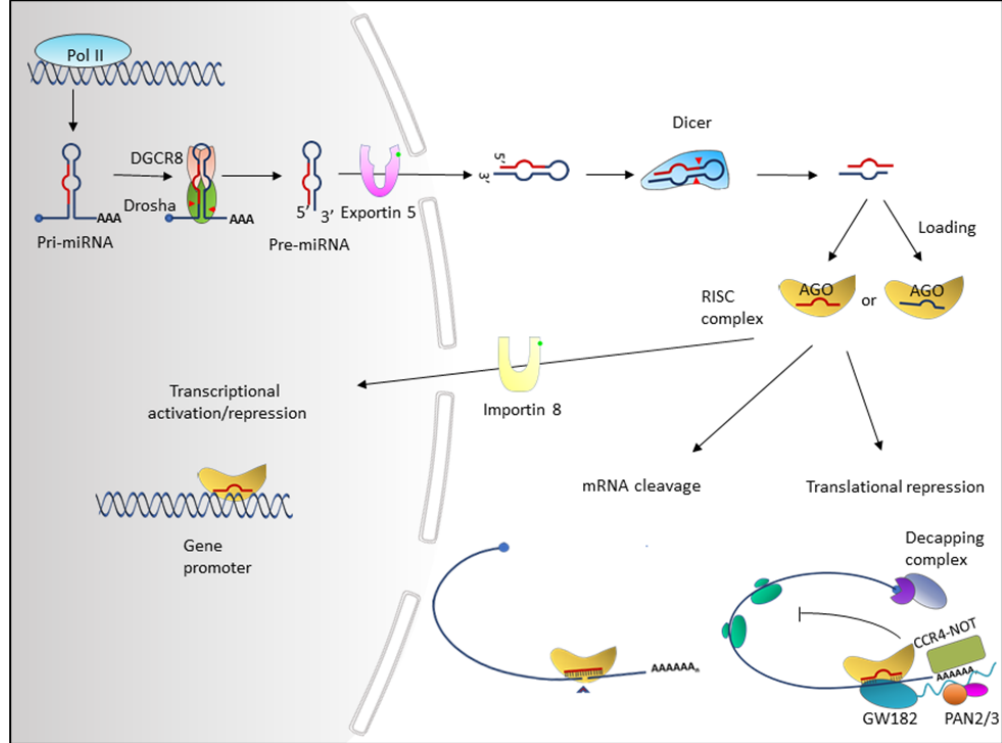
Figure 1. Biogenesis and functions of miRNA. MicroRNAs (miRNAs) are usually transcribed by polymerase II in the nucleus to generate primary microRNAs (pri-miRNA) transcripts. In the canonical pathway, the maturation of miRNAs is then performed by the microprocessor complex comprising of DROSHA, RNase III, and DCGR8. The microprocessor complex cleaves both strands of pri-miRNAs near the base of the primary stem loop, generating pre-miRNAs. Following cleavage, pre-miRNAs are actively transported from the nucleus to the cytoplasm by the Exportin 5/Ran-GTP complex. In the cytoplasm, RNase III endonuclease Dicer recognizes and cleaves pre-miRNA near the terminal loop, releasing a small RNA duplex. Subsequently, either strand (-5p or -3p) of the miRNA duplex is loaded into an AGO protein to form a miRNA-induced silencing complex (miRISC). Functionally, miRNAs direct the miRISC complex to target genes and modulate its expression by promoting either mRNA degradation and/or translation inhibition in the cytoplasm. The AGO protein of miRISC complex binds GW182 family proteins, which serve as scaffolds for multiple proteins including PAN2/3, and CCR4-NOT complexes. While the miRISC complex hinders the binding of eIF4F complex, PAN2 / 3 and CCR4-NOT mediate the poly(A) deadenylation of target mRNAs. The target mRNA is further decapped by a decapping complex and subjected to degradation via the exoribonuclease XRN1. In addition, the miRISC complex can be transported into the nucleus via Importin 8 / RAN-GTP complex and binds to target gene promoters to regulate its